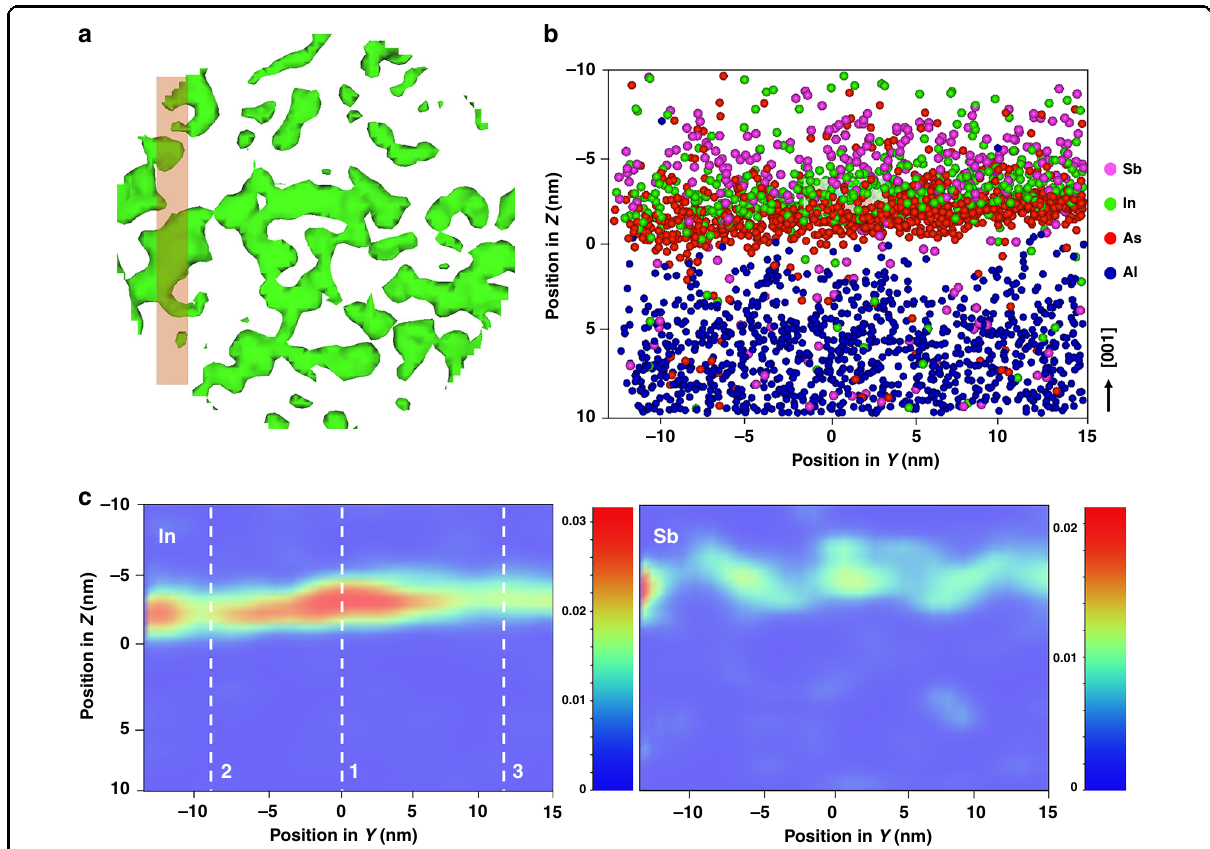
Fig. 6 APT investigation of the QD region. a A 30 nm diameter slice of the iso-concentration surface created with In = 2.0 at.%, showing the In-rich areas, the shaded region represents a 5-nm thick cross-sectional slice taken to plot concentration maps of the elements; b cross-sectional atom map of the shaded region from panel a , showing the distribution of constituent elements (Al, As, In, and Sb); c cross-sectional concentration maps of In and Sb, the dotted lines indicate: (1) In-rich region, (2) In-poor region, and (3) In-poor but As-rich region. The exact composition as reported in the color bars is not completely quantitative due to the spatial blurring from trajectory aberrations that occurs during atom probe, where matrix material from the vicinity of the QDs can appear to be from inside the